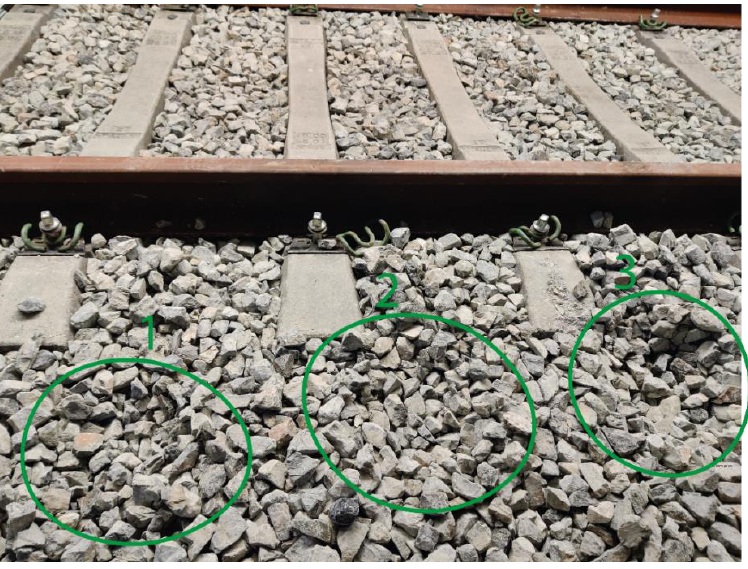
Figure 4. Holes dug in the ballast (marked in green).